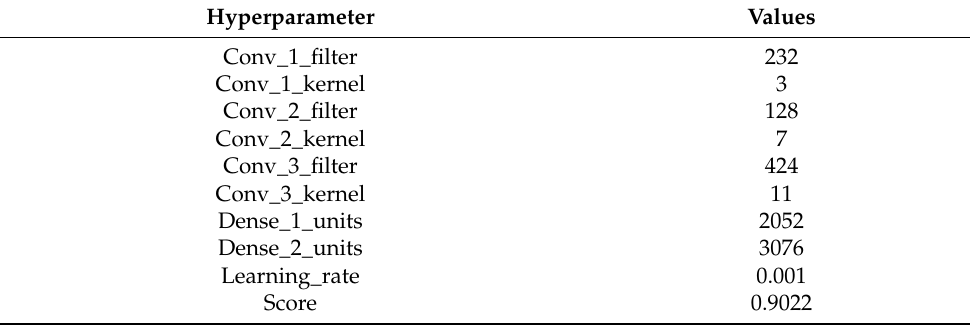
Table 3. Summary of VGG16 Models hyperparameter search result (Best Trials).